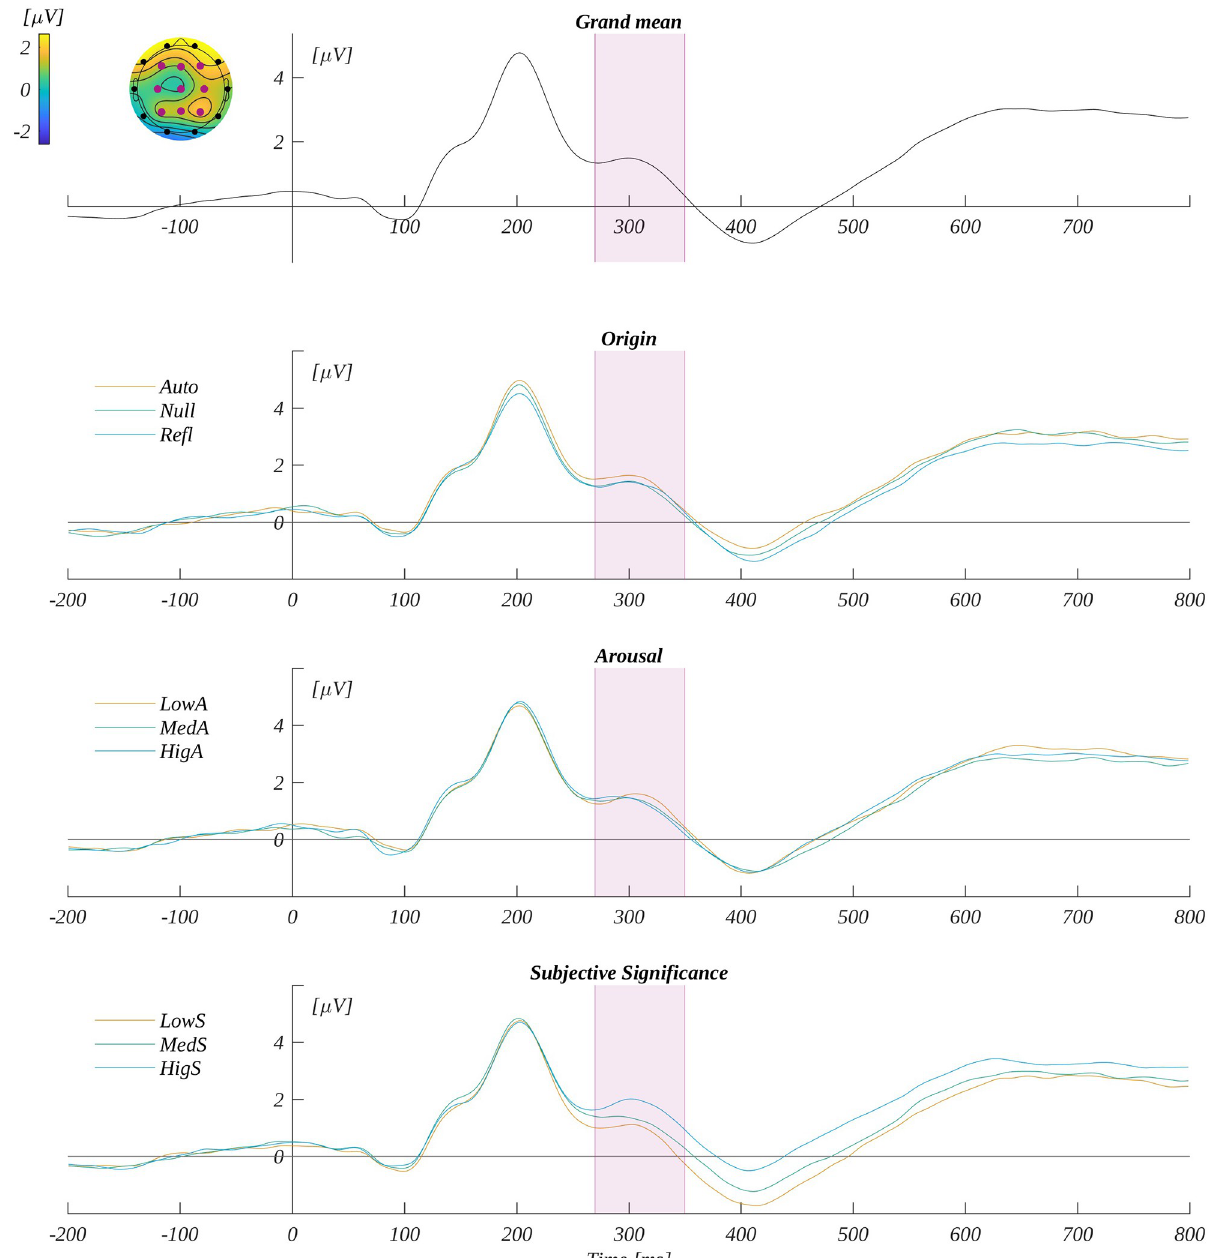
Fig 4. P300 potential. The upper plot: the grand average across electrodes from ROI P300 . The marked time-interval was selected for the P300 analysis. The insert shows the topography of the mean potential from this period with the electrodes forming the ROI P300 marked with pink dots. The three bottom plots are the time courses for ERP averaged across electrodes from ROI P300 for each level of origin, arousal and subjective